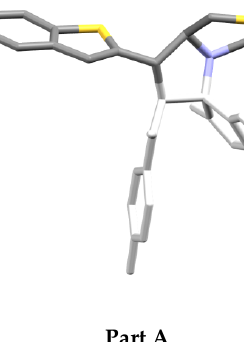
Figure 4. The structure of conformers A and B as reported by the disorder model in the X-ray structure. The fixed part is made in light grey color and the methanol molecule was omitted for more clarity.